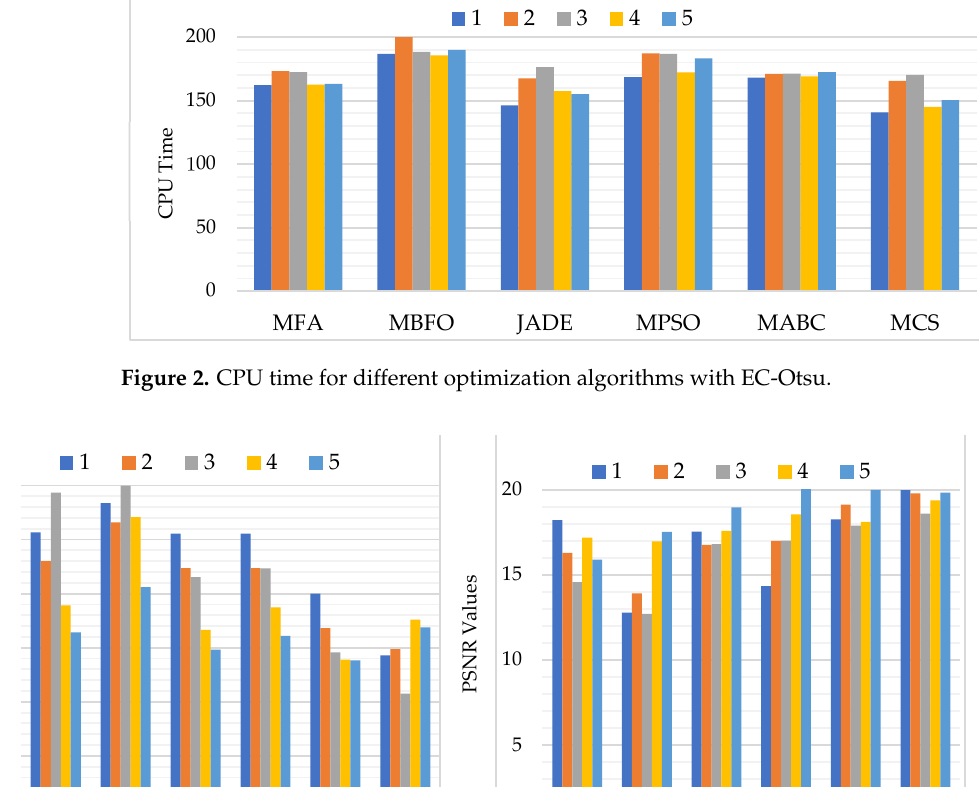
Figure 2. CPU time for different optimization algorithms with EC-Otsu. Table 2. CPU time using different optimization algorithms with the EC-Otsu and MCE entropy methods. segmentation levels (2, 5, 8, and 12) are shown in Appendix A Tables A1–A3. The analysis of the algorithms is discussed below.